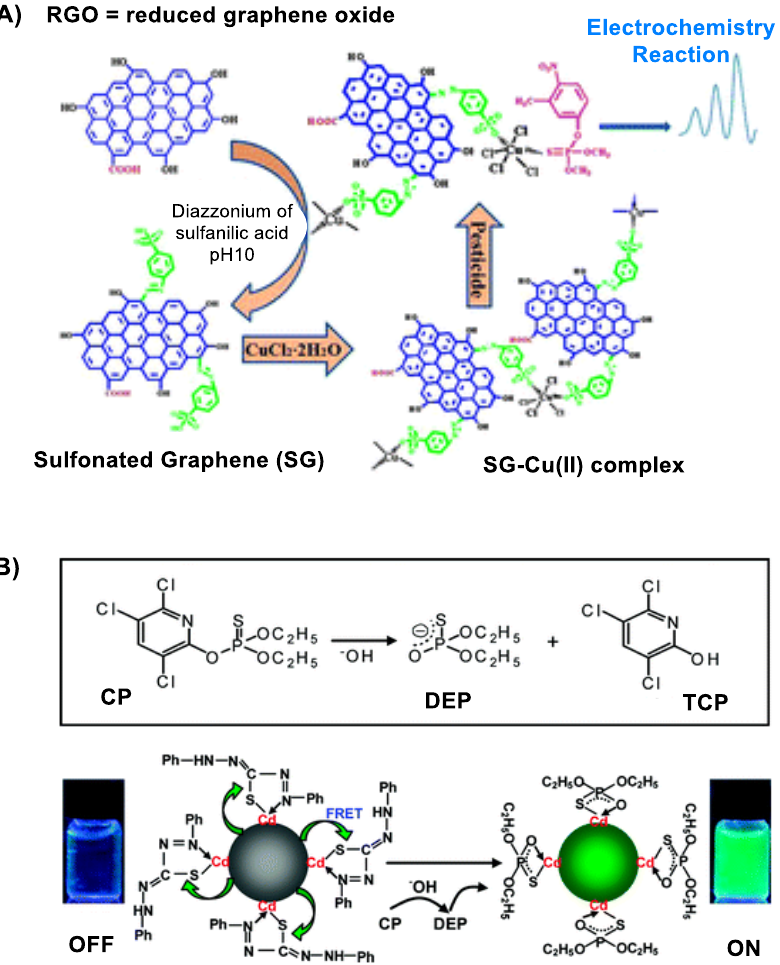
Figure 2. ( A ) A copper (II)-functionalized graphene nanocomposite applied for sensing sulfur- containing organophosphate (OP) pesticides. Reproduced with permission from [51], Copyright 2013, The Royal Society of Chemistry. ( B ) Dithizone-coordinated CdTe quantum dot (QD) applied for chlorpyrifos detection. Its concept of detection involves restoration of its fluorescence by dithizone replacement with diethylphosphorothioate, a hydrolytic byproduct of chlorpyrifos. Reproduced with permission from [56], Copyright 2010, American Chemical Society.